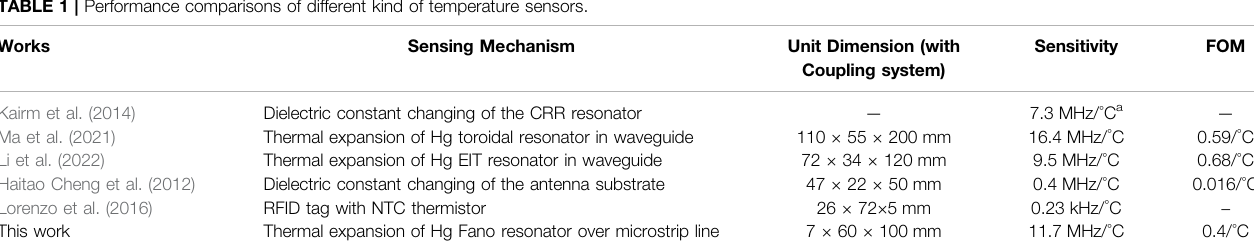
TABLE 1 | Performance comparisons of different kind of temperature sensors.